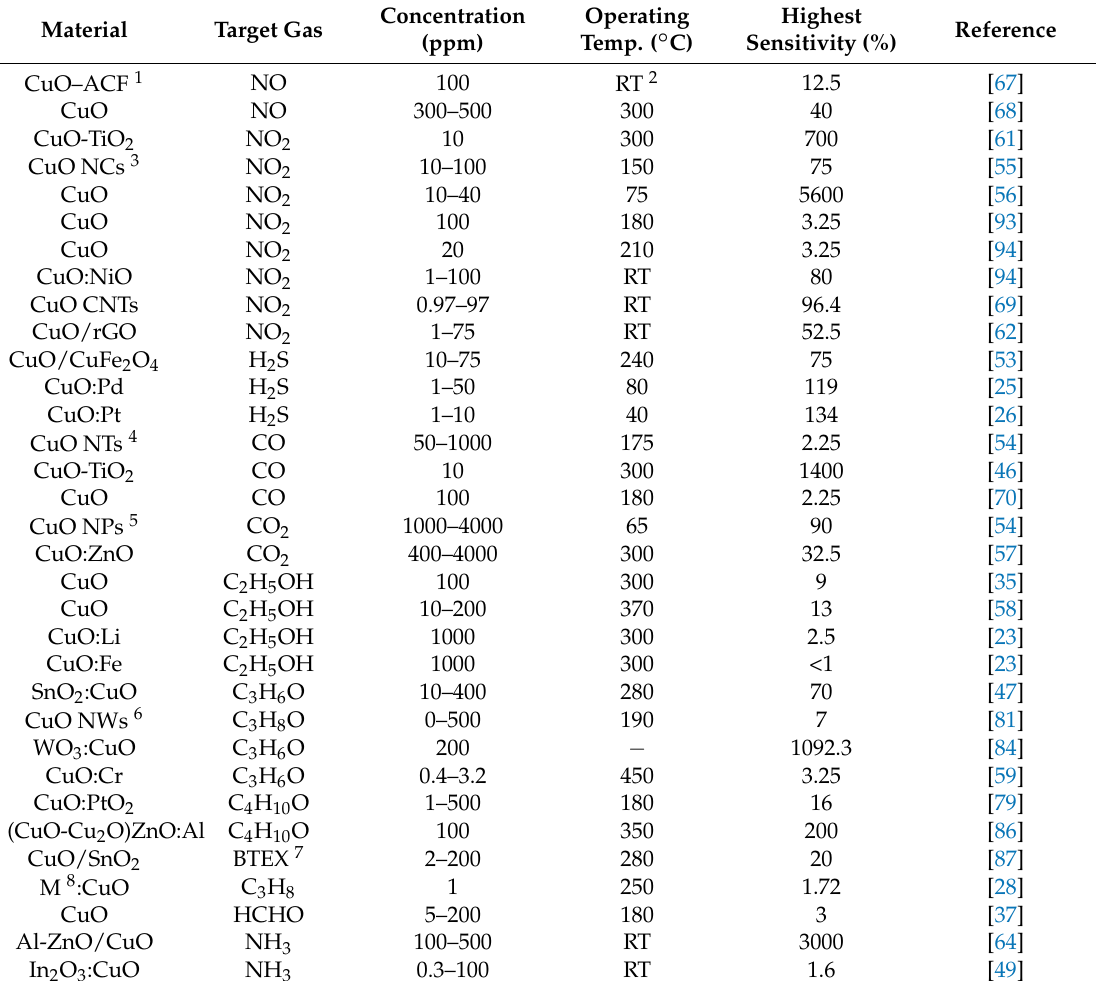
Table 2. Summarized information of CuO-based gas sensors presented in the